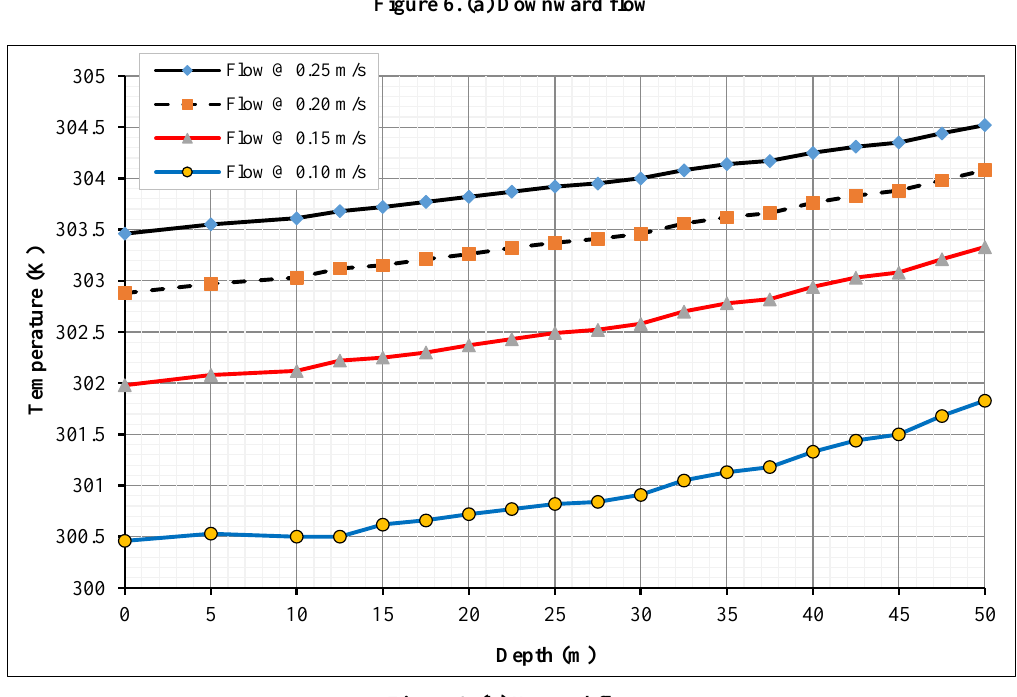
Figure 6. (b) Upward flow Figure 6. Water temperature distribution comparison at different flow velocities for the half loading double U-tube Figure 7 depicts the comparison between both geometry orientations at different flow velocities. The highest temperature difference between the inlet and exit sides of the water was experienced at the lowest examined mass flow rate, which is 0.136 kg/s, corresponding to 0.2 m/s. It was 5 and 5.7°C for the single and half- loading double U-tube heat exchangers, respectively. The temperature difference values revealed that the cooling load achieved by the downward flow was higher than that of the upward flow side. The ( 𝜉) values produced a heat transfer load enhancement in the downward leg ranging between 35% and 68% as calculated from Equation